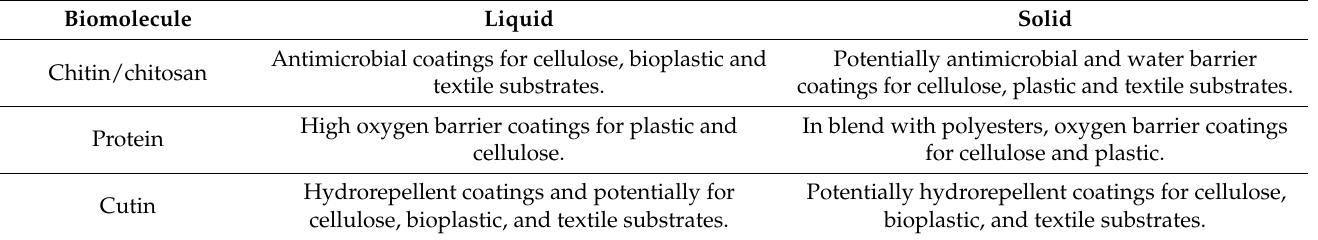
Table 4. Predictable perspectives for chitin/chitosan, protein and cutin on different substrates. Biomolecule Liquid Solid Antimicrobial coatings for cellulose, bioplastic and Potentially antimicrobial and water barrier Chitin/chitosan textile substrates. Protein